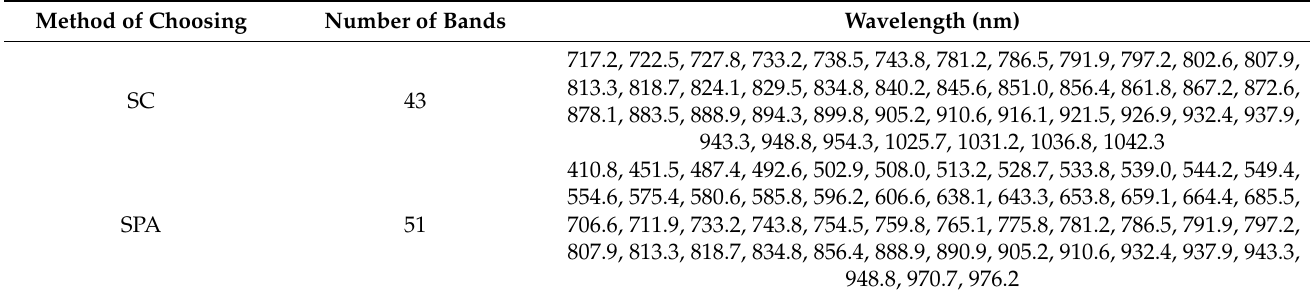
Figure 8. Correlation and p -value of the average spectrum and component content. The solid line represents the correlation curve and the dotted line is the p-value curve. Table 5. Optimal bands extracted using an SPA and an SC algorithm.